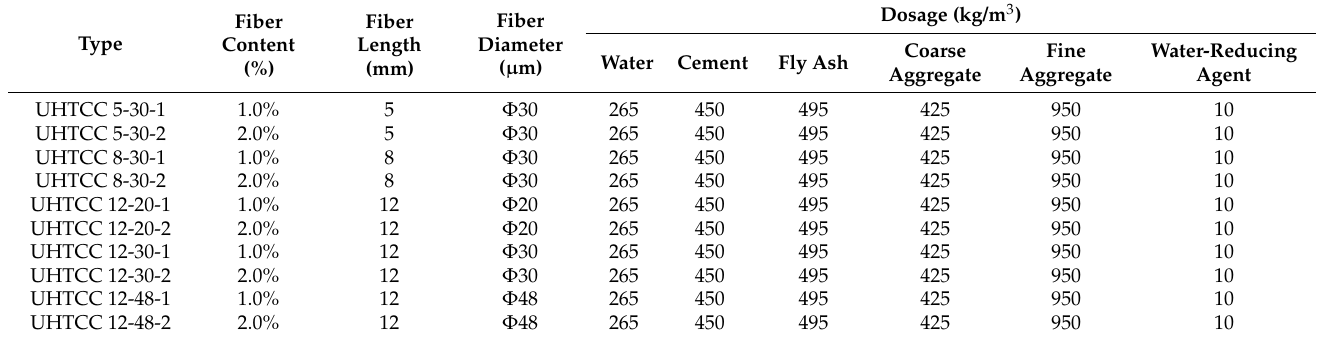
Table 2. Mix ratio of